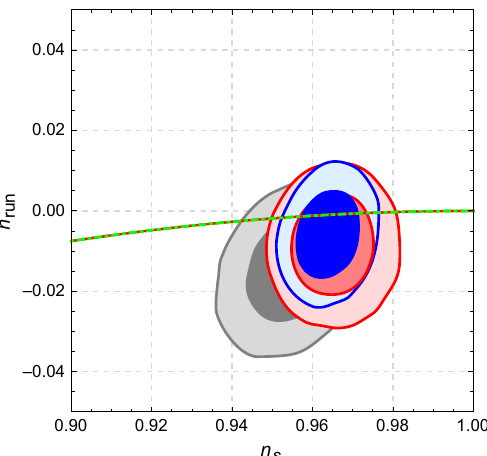
Fig. 2 n s − n run diagram. The area corresponds to Planck data and n s − n run trajectories relate to our model.The solid red, dashed orange and dot-dashed green lines correspond to Γ 0 values: 1 . 82 × 10 − 1 . 64 , 1 . 54 × 10 − 1 . 64 and1 . 38 × 10 − 1 . 64 .Inthesecurveswehavefixed (ξ 2 , C γ ) as: (10 8 λ, 70) and the number of e-folds as: N e = 60